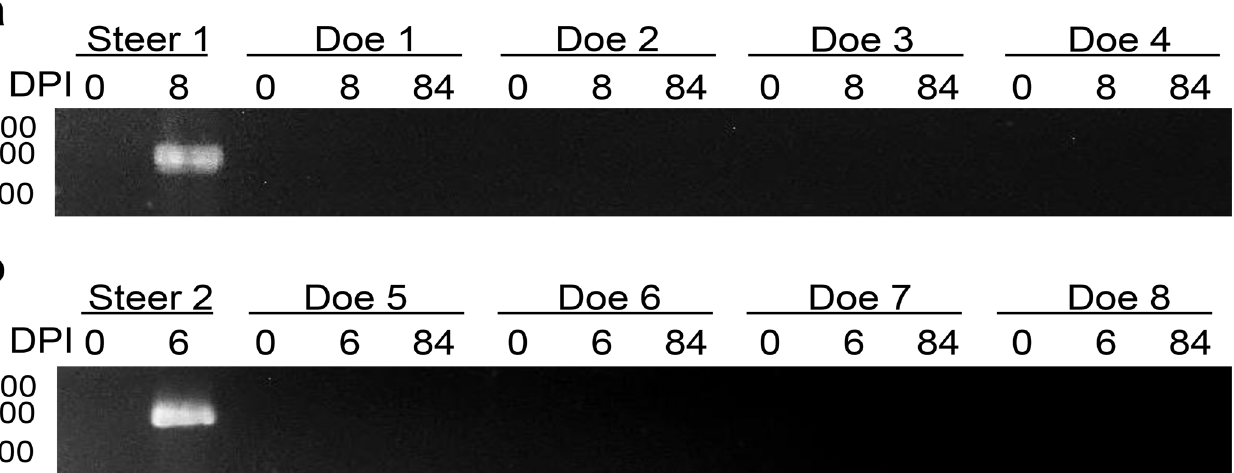
Fig 1. Evaluation of Babesia bovis infection by nested PCR. Amplicons were separated in 2% agarose by electrophoresis. White-tailed deer challenged with either B . bovis a) blood stabilate or b) a larval extract containing B . bovis sporozoites. Steer 1 and 2 control for the inocula. DPI: day post-inoculation. Molecular size is indicated on the left.